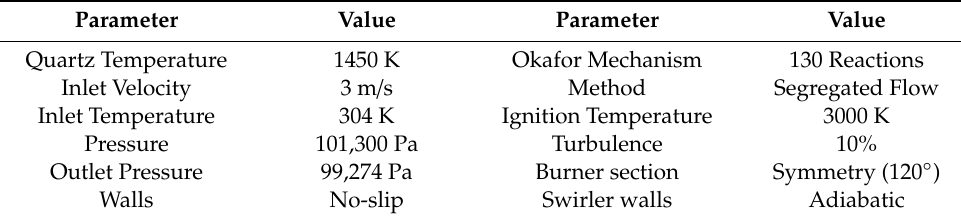
Table 1. Boundary conditions; atmospheric conditions.